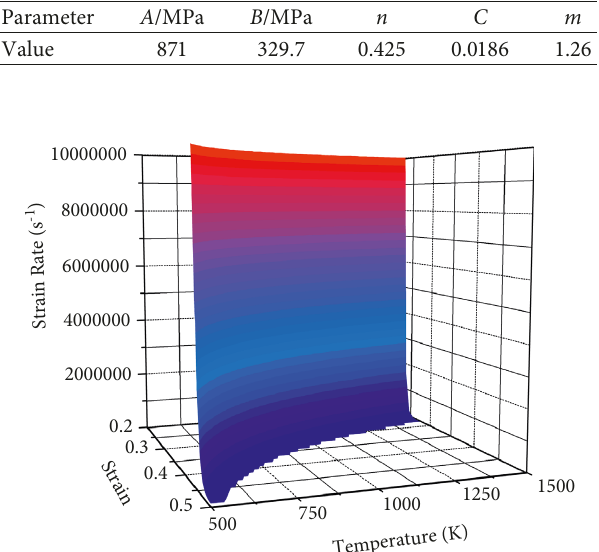
Figure 9: Critical condition for the initiation of gouging in a U71Mn steel